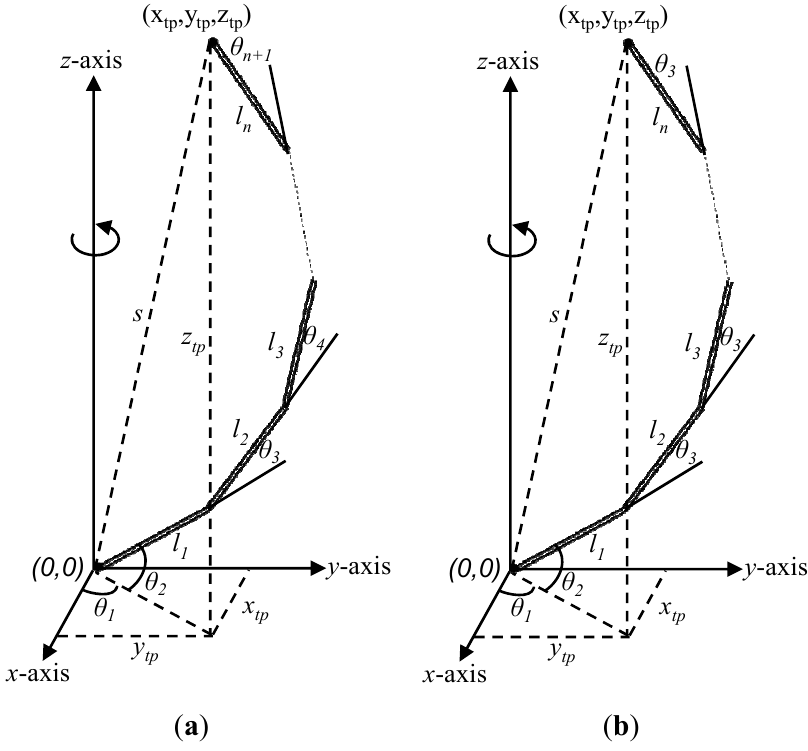
Figure 2. The manipulator used in experiments [14]. The draft of the manipulator using the SolidWorks software ( left ). The mechanical design of the manipulator ( right